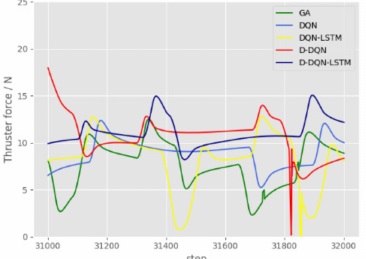
Figure 14. Thrust curve between 31,000 and 32,000 in a static environment.